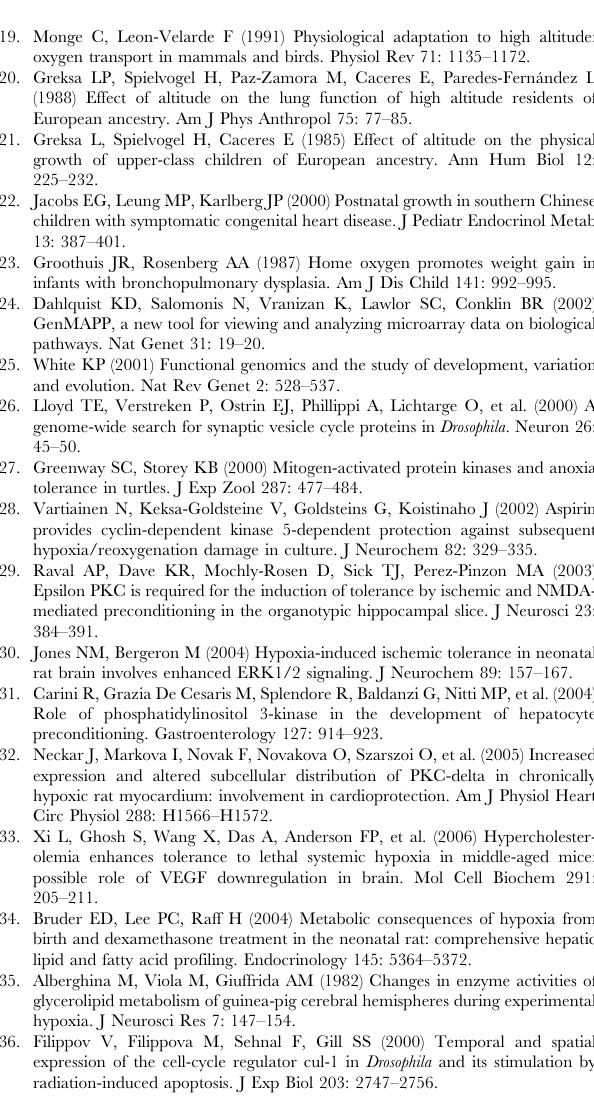
Found at: doi:10.1371/journal.pone.0000490.s001 (0.08 MB Table S2 Eclosion rate of P-element alleles in hypoxic condition Found at: doi:10.1371/journal.pone.0000490.s002 (0.04 MB Table S3 List of Specific Primers for sqRT-PCR Found at: doi:10.1371/journal.pone.0000490.s003 (0.03 MB Figure S1 The eclosion rate of individual parental lines under 5% of O 2 . The measured eclosion rates ranged from 0 to 28 percent (4.7% in average) demonstrating significant levels of functional variability among these lines with respect to the ability to survive hypoxic condition (ANOVA, p =0.022).